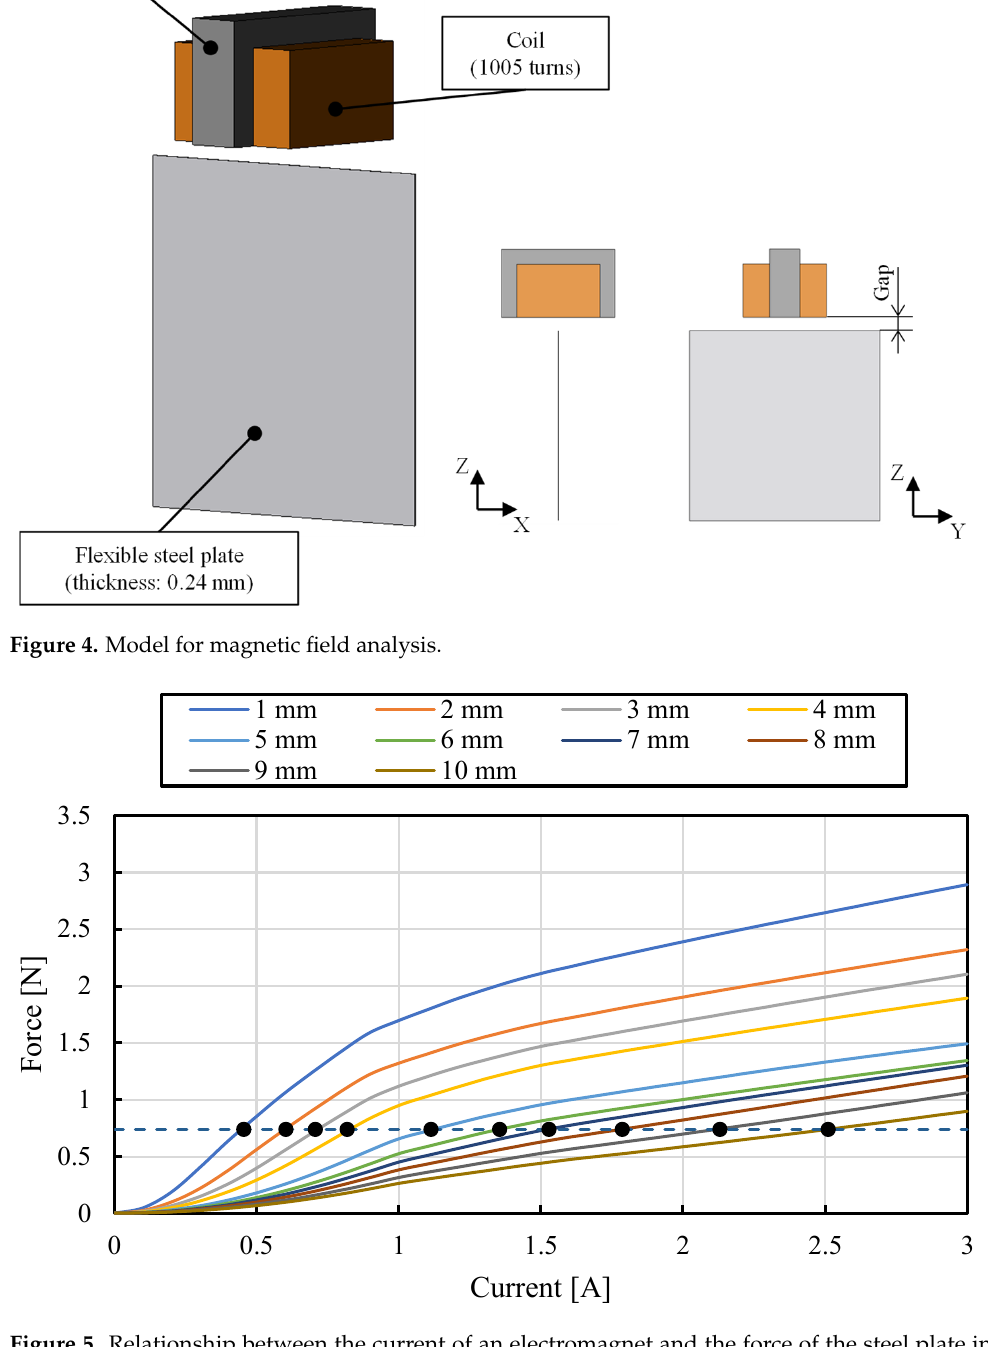
between the solid and dashed lines, and show possible conditions for levitation of the steel each gap. The dashed line shows the weight of the steel plate. The dots ( ･ ) show intersection points